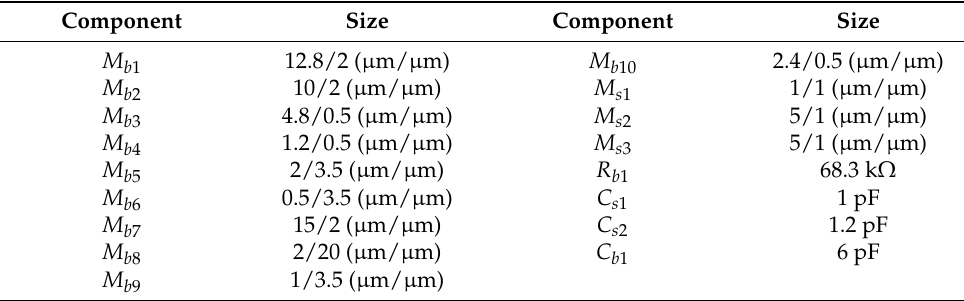
Table 3. Sizes of the Components in Biasing